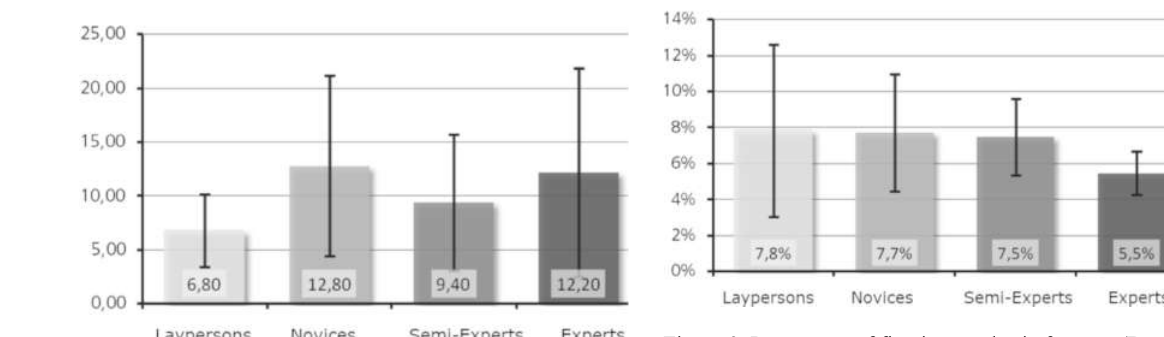
Figure 9. Percentage of fixations on basic features